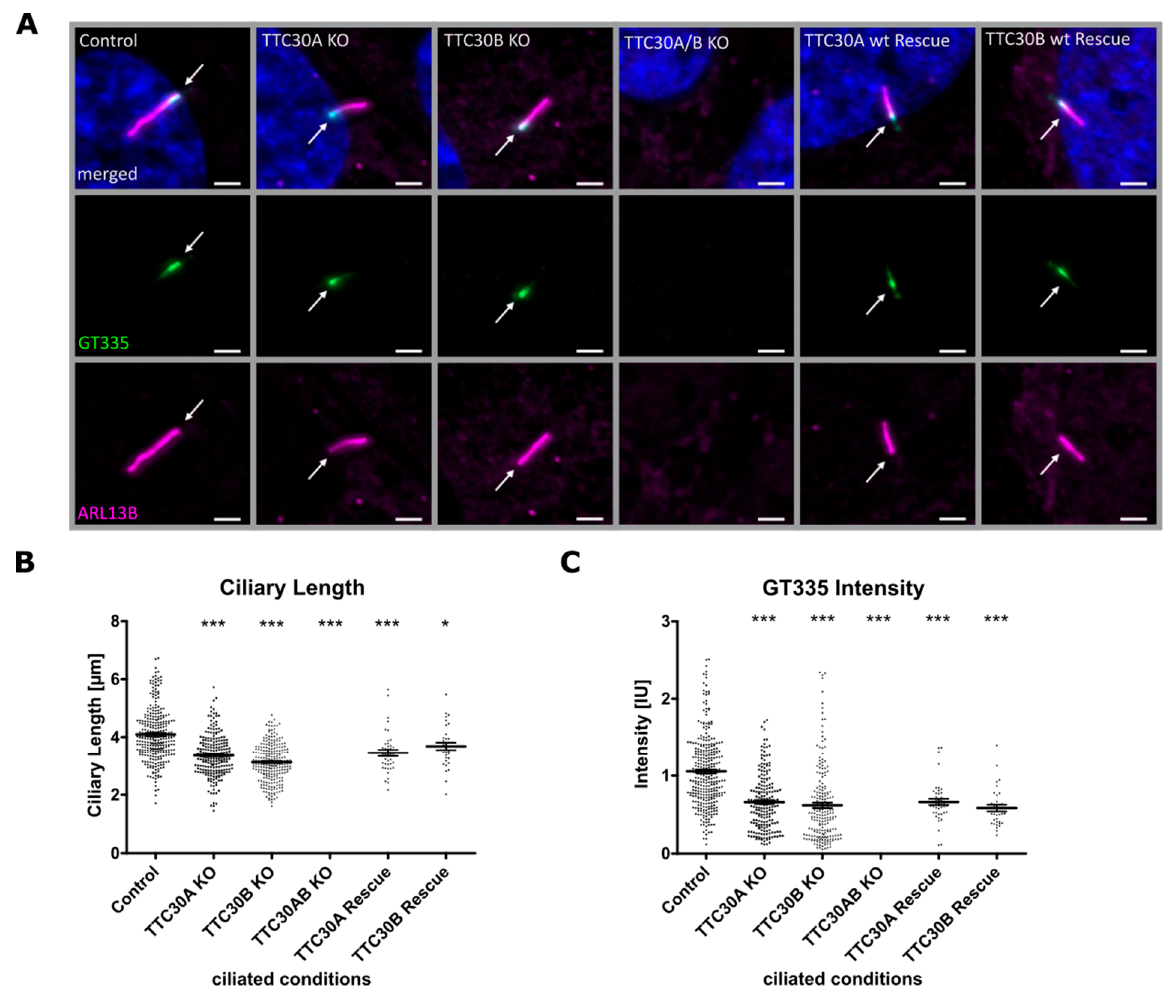
Figure 3. ( A ) Fluorescent light microscopy images of hTERT-RPE1 control, TTC30A, TTC30B, TTC30A/B double-KO cells, TTC30A and TTC30B rescue (from left to right) are shown. The cells were stained for ARL13B (magenta) and polyglutamylated tubulin (GT335, green), DNA is marked in dark blue and co-localization is shown as white. The scale bar measures 2 µm. In TTC30A/B, single- and double-KO as well as rescue cells’ ciliary length ( B ) was measured using ARL13B as an indicator for ciliary length. Measurement of fluorescent intensity of polyglutamylated tubulin staining is shown in ( C ). In the scatter dot plots, results gained in two independent experiments are shown with each dot representing one cilium. For statistical analysis, the mean was calculated. p values below 0.05 are represented by * and below 0.001 by ***. Error bars represent the s.e.m.